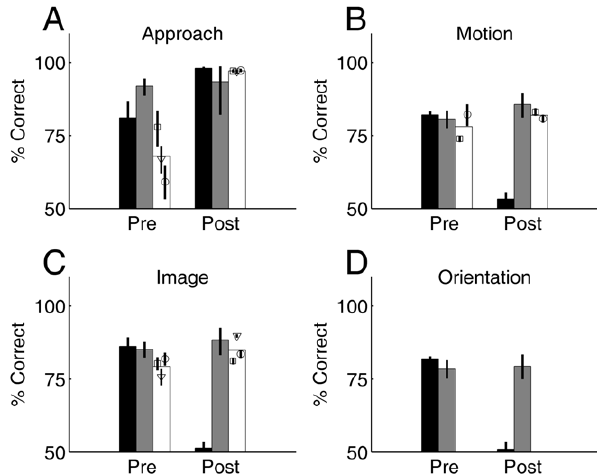
Figure 7. Summary of population results. Each panel shows pre- and post-lesion performance for V1 lesion (subject S1, black bar), medial extrastriate lesion (subject S2, gray bar), and the average of the sham lesion controls (S3–5, white bar), as well as the individual sham control subjects (superimposed symbols). Error bars indicate 95% binomial confidence intervals. A. Approach Salient Visual Target task (statue target). B. Motion Discrimination task, 85% coherent motion. C. Image Discrimination task. D. Orientation Discrimination task, which was learned before surgery by only two subjects, S1 and S2. The V1 lesion subject had large and highly significant deficits in motion, image, and orientation discrimination tasks, whether compared to its own pre- lesion performance, compared to sham or extrastriate lesion perfor- mance, or compared to post-lesion performance of the same subject on the approach